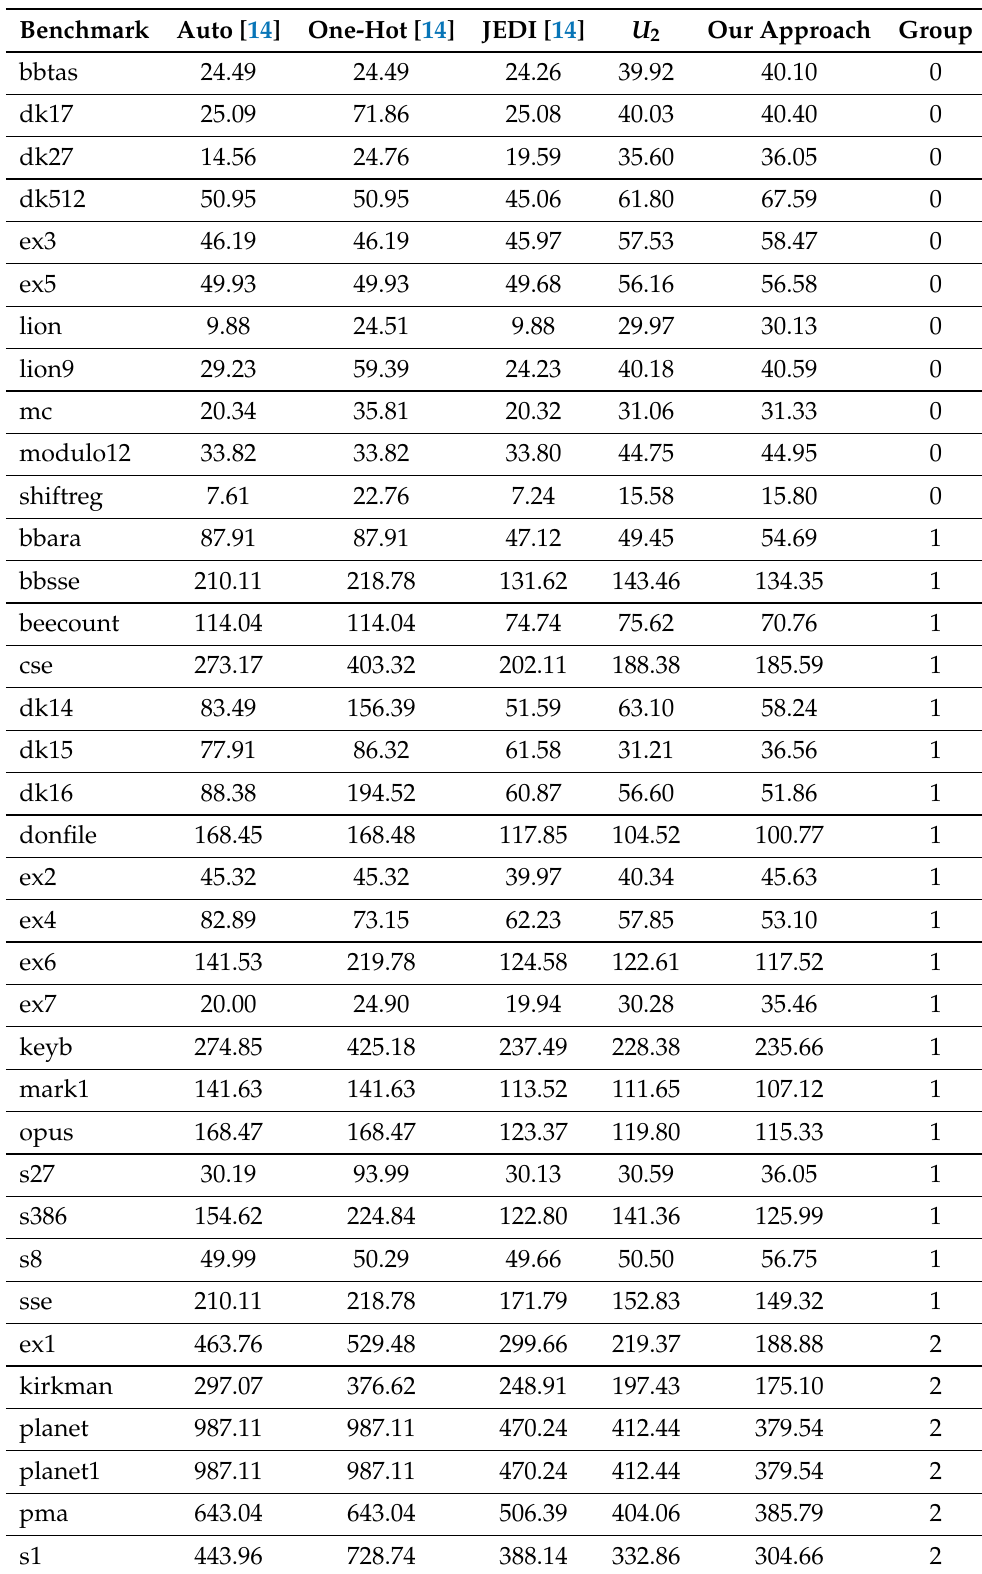
Table 19. Experimental results (area–time